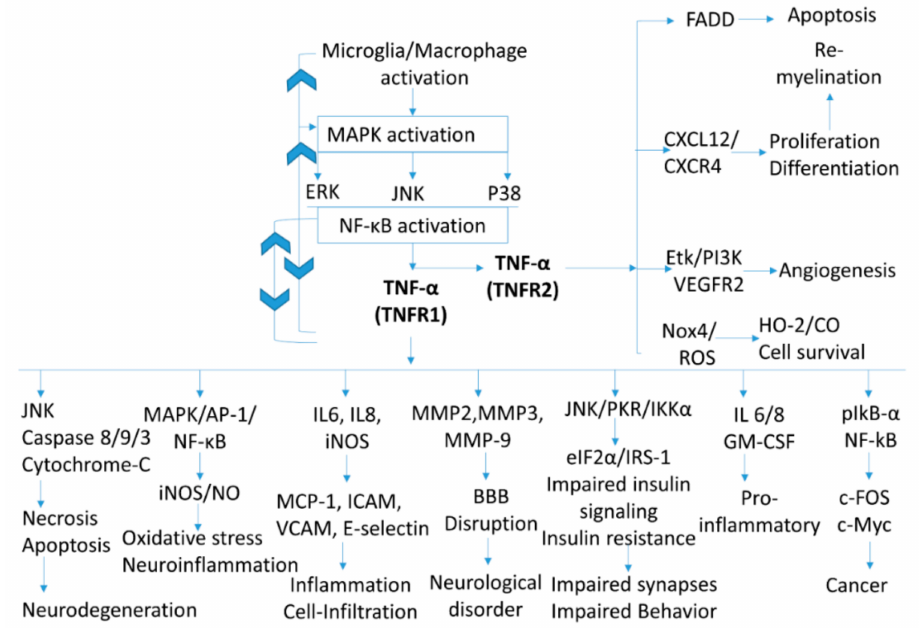
Figure 1. Receptor-mediated endogenous signaling pathways of tumor necrosis factor-alpha (TNF- α )